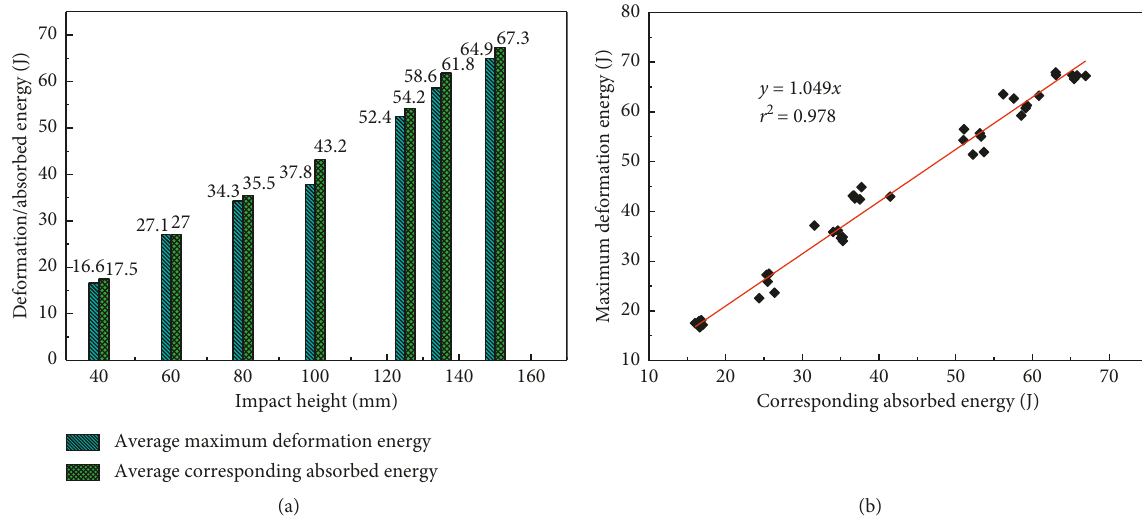
Figure 6: Maximum deformation energy and corresponding absorbed energy.